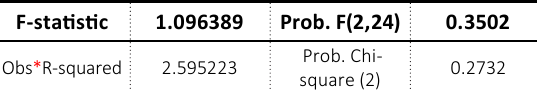
Table 2. Breusch-Godfrey serial correlation LM